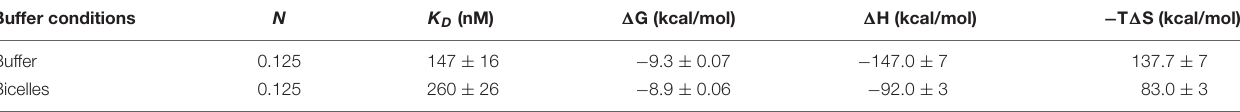
TABLE 2 | ITC titration with PEX5 NTD (1–315) on PEX14 NTD